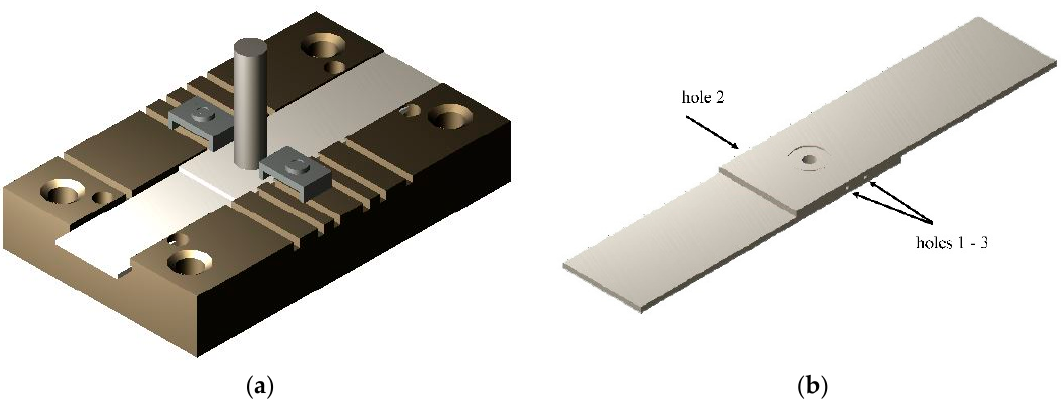
Figure 1. Experimental setup, ( a ) clamping system; and ( b ) details of a specimen with holes for the thermal analysis.